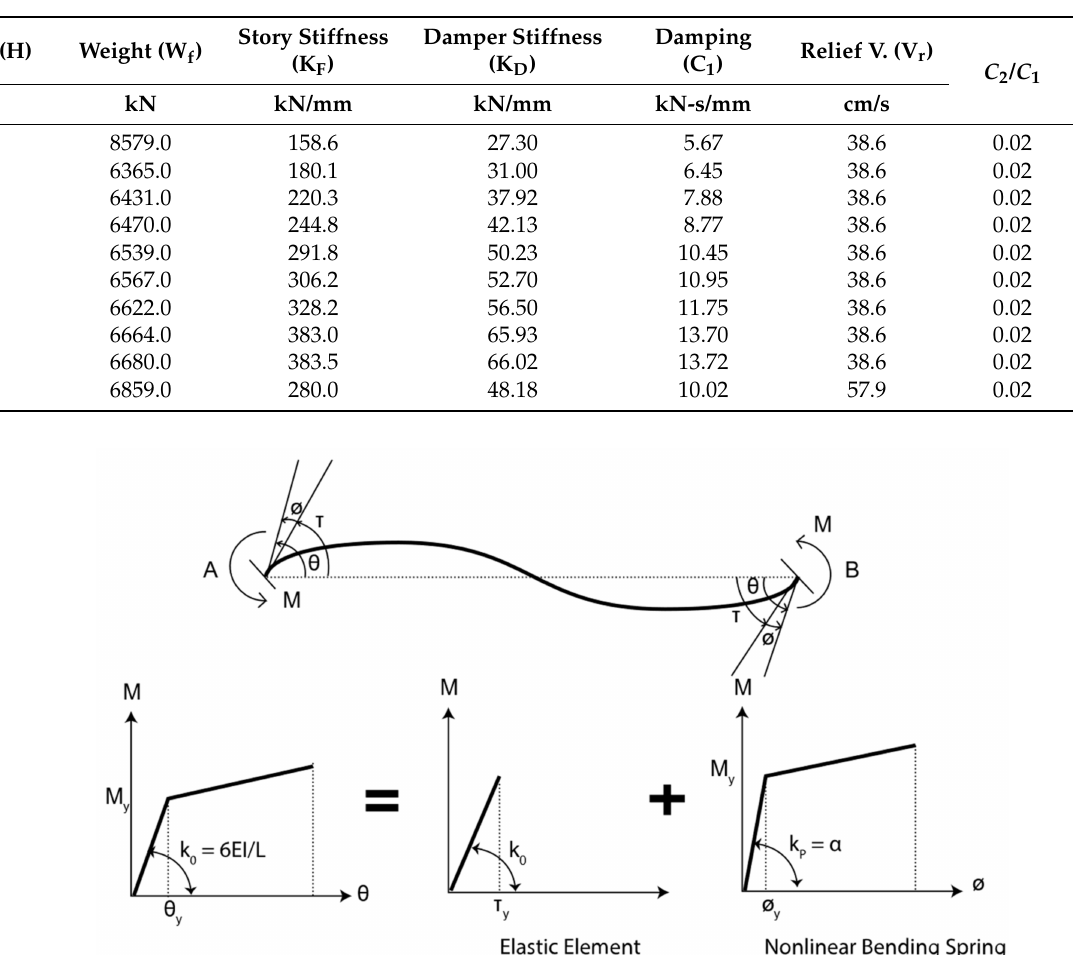
Table 6. Technical parameters of oil dampers for 10-story building.